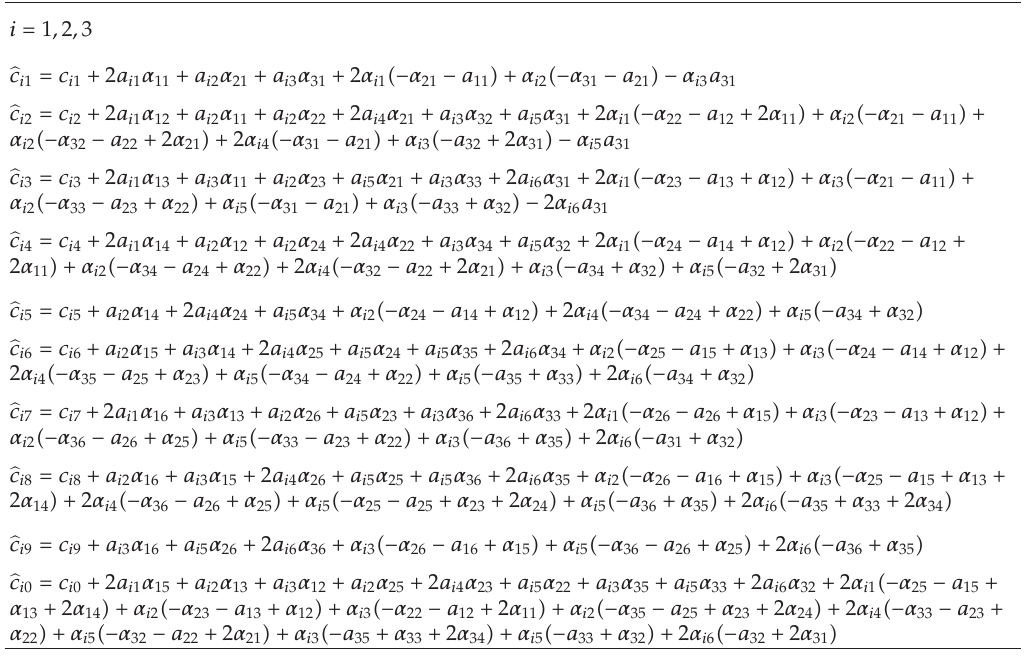
Table 2: Relationships between the coe ffi cients of (cid:17) f (cid:4) 3 (cid:5) (cid:3) z (cid:6) and those of f (cid:4) 3 (cid:5) (cid:3) z (cid:6) , f (cid:4) 2 (cid:5) (cid:3) z (cid:6) and ϕ (cid:4) 2 (cid:5) (cid:3) z (cid:6) as they result from condition (cid:3) A.19 (cid:6) .